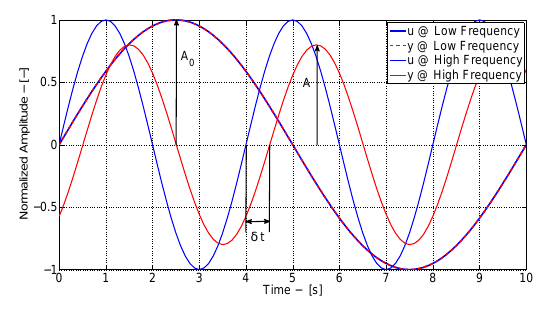
Figure 4: Illustration of the frequency response test. Tørdal and Klausen (2013)